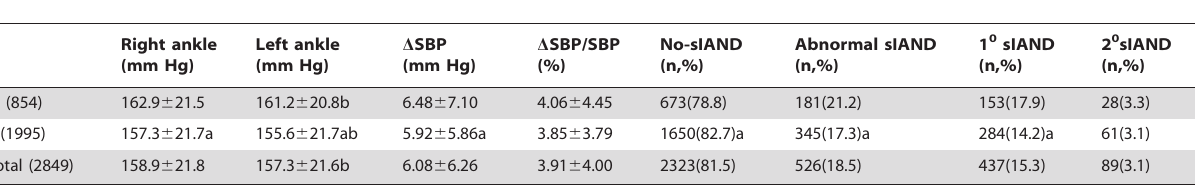
Table 2. Comparison of ankle SBP and sIAND prevalence between two gender groups.